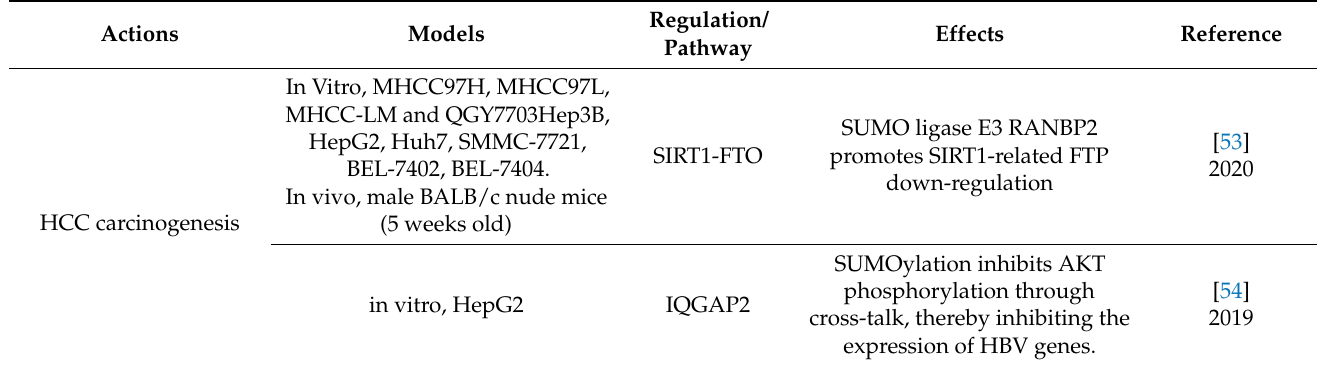
Table 1. The Role of SUMOs in HCC progression.